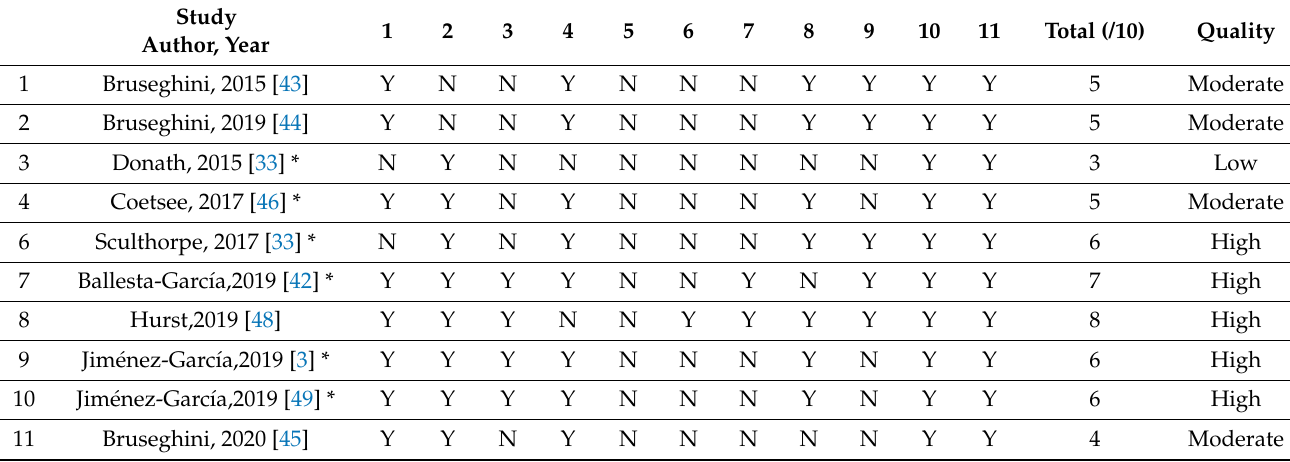
Table 6. PEDro scale of the included